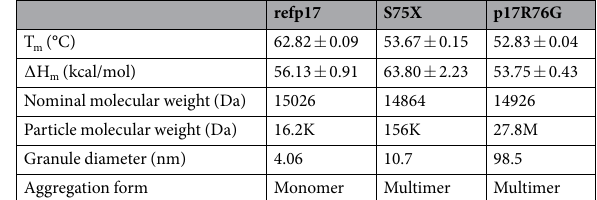
Table 1. Values of Tm and Δ Hm determined through thermal denaturation at pH 7.4 and protein size measured by dynamic light